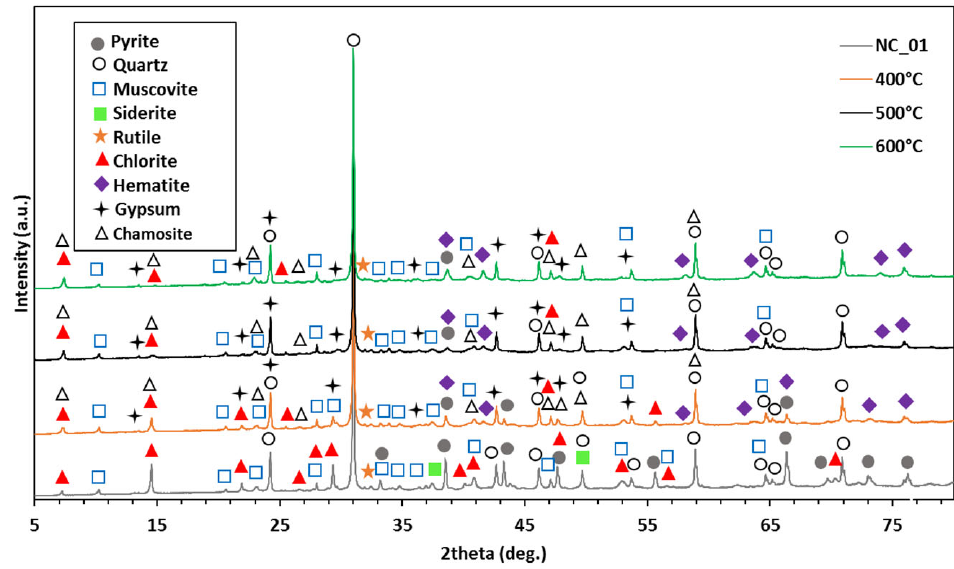
Figure 3. XRD scans of the Neves Corvo waste rock (NC_01) before and after microwave roasting 400, 500, and 600 ◦ at 400, 500, and 600 °C.